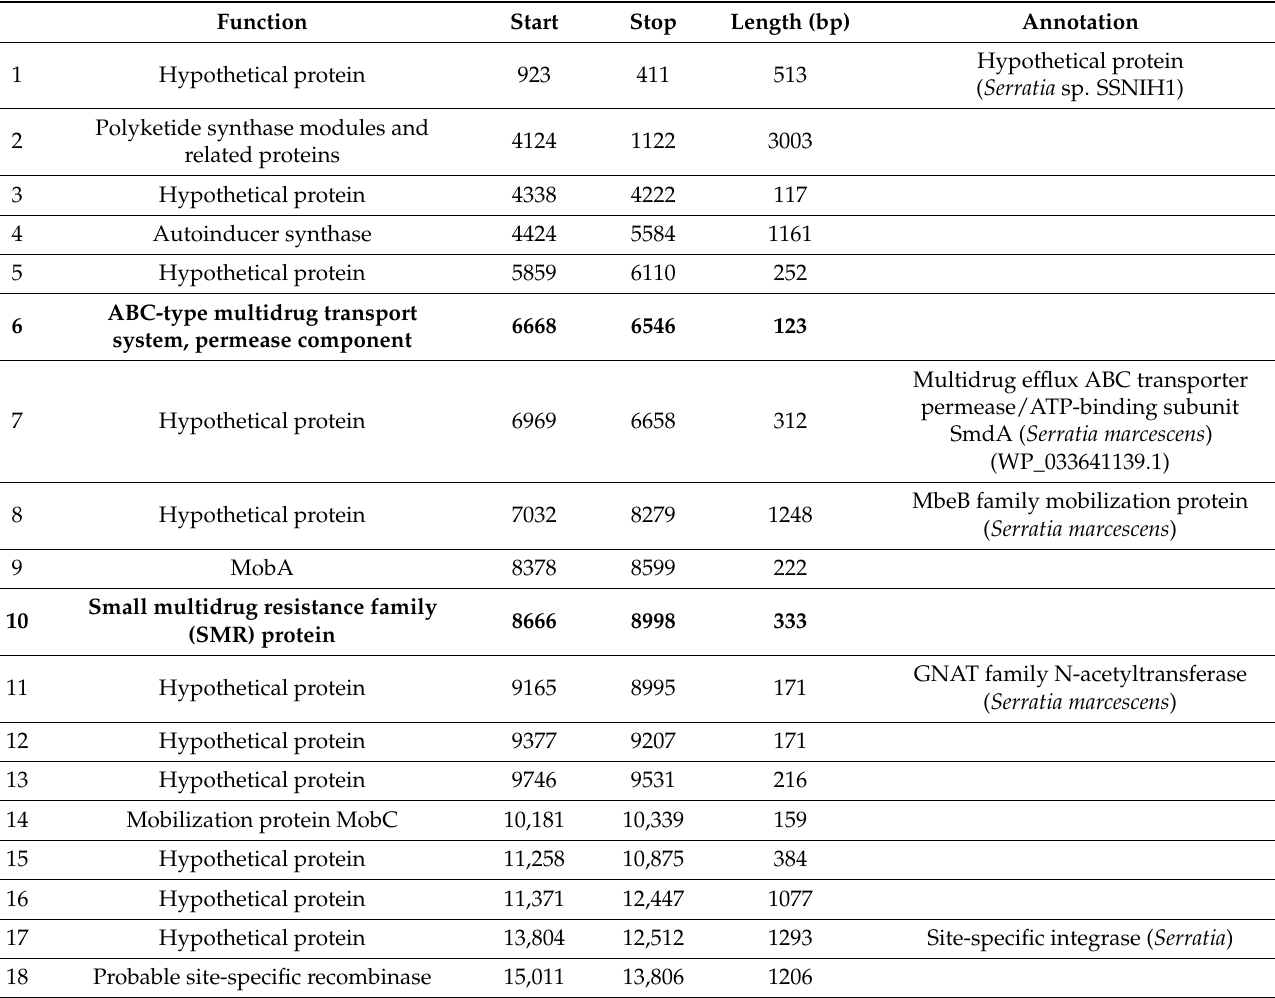
Table 4. Gene lists of genomic island 76 of Serratia sp. HRI (5 688 450 bp-5 725 416 bp, GC